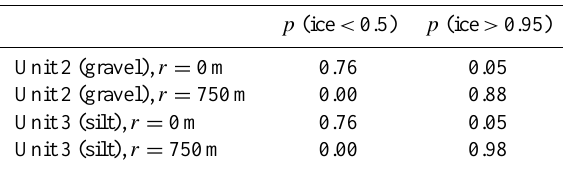
Further illustration of the spatial and temporal changes in resistivity pdfs are shown in Fig. 8. The resistivity pdf is dis- played as a function of distance from the lake center at the same depths (15 and 50 m) shown in Fig. 7, corresponding to gravel (Fig. 8a, c, and e) and silt (Fig. 8b, d, and f) locations. High probabilities, i.e., the peaks in Fig. 7, correspond to dark-shaded areas in Fig. 8. Images are shown for three dif- ferent time steps in the SUTRA simulation for the hydrostatic 6 m deep lake scenario: 100 years (Fig. 8a and b), 240 years (Fig. 8c and d), and 1000 years (Fig. 8e and f). Approxi- mate ice-saturation values, translated from the ice versus re- sistivity relationships for each lithology shown in Fig. 2, are displayed on the right axis of each panel in Fig. 8, and true resistivity values are plotted as a dashed line. Observations from Fig. 8 include the following: 1. Outside the lake boundary, pdfs are significantly more sharply peaked (darker shading) for the gravel unit